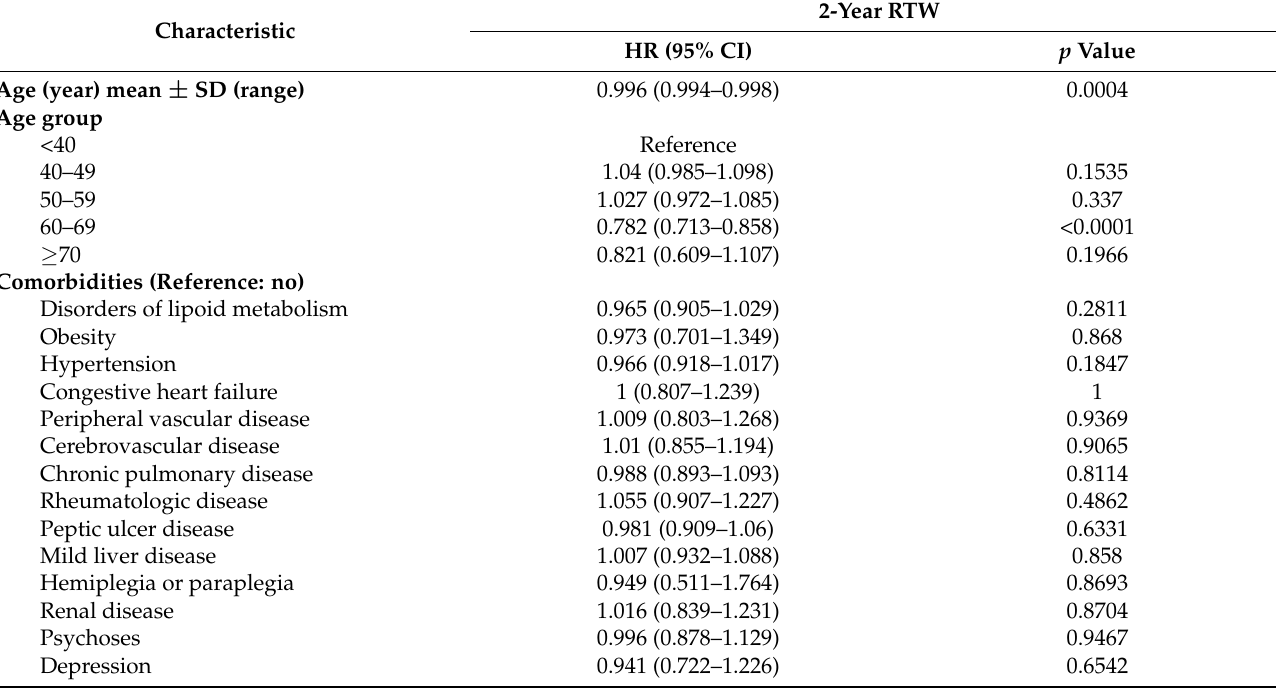
Table 2. Univariate analysis of RTW in Cox proportional hazards